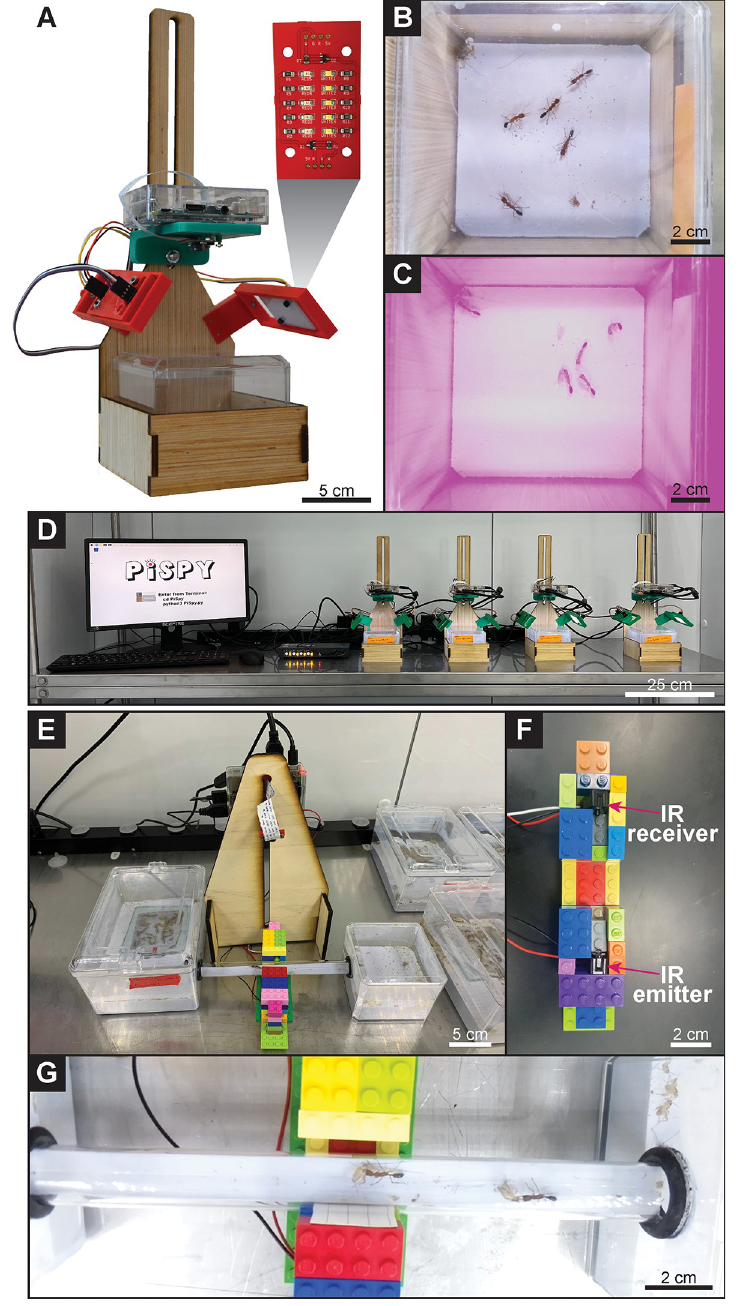
Fig 3. Monitoring Harpegnathos saltator ant behavior. A. Custom designed PiSpy setup for ant behavioral recording. The inset PCB boards provide LED lighting that cycles between red and white as specified by the user. B. Sample image from a video (S5 Video) of an H . saltator colony recorded during the day with white lighting from the PiSpy LED PCBs. C. Sample image from a video (S6 Video) of an H . saltator colony recorded during the night, with red lighting from the PiSpy LED PCBs. D. Multi-PiSpy setup using a KVM switch to control all four PiSpy units with a single monitor, keyboard, and mouse. E. Sample image still from the recording of H . saltator feeding. An IR break beam connected to PiSpy was placed such that it would be triggered when an ant crossed a tube connecting a nest box to a foraging arena, and PiSpy was used to record ants going to the arena and returning carrying crickets (S7